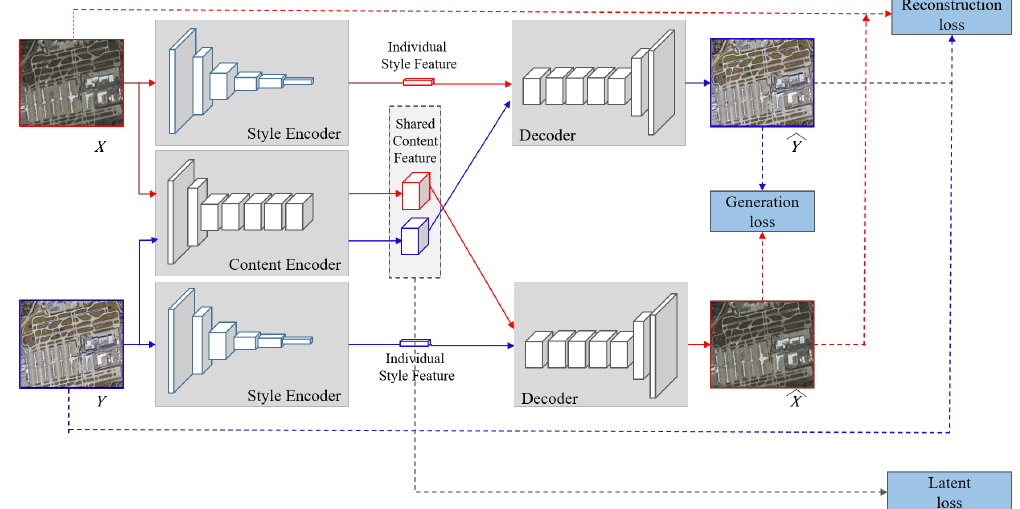
Figure 3. The overview of the proposed representation learning